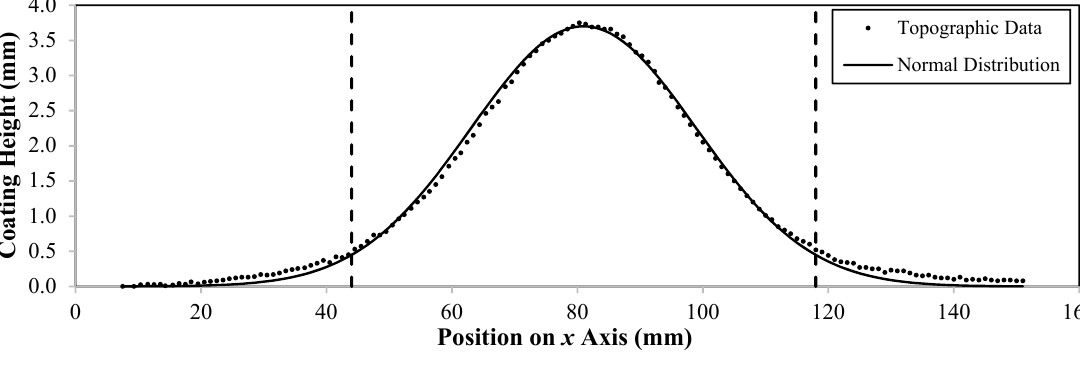
Figure 3. Representative surface topography plot with fitted normal distribution (vertical axis is exaggerated for clarity) to determine spray pattern